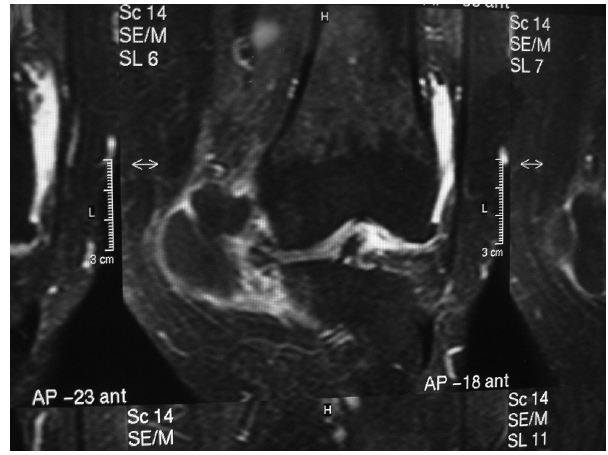
Figure 2 - T1 coronal